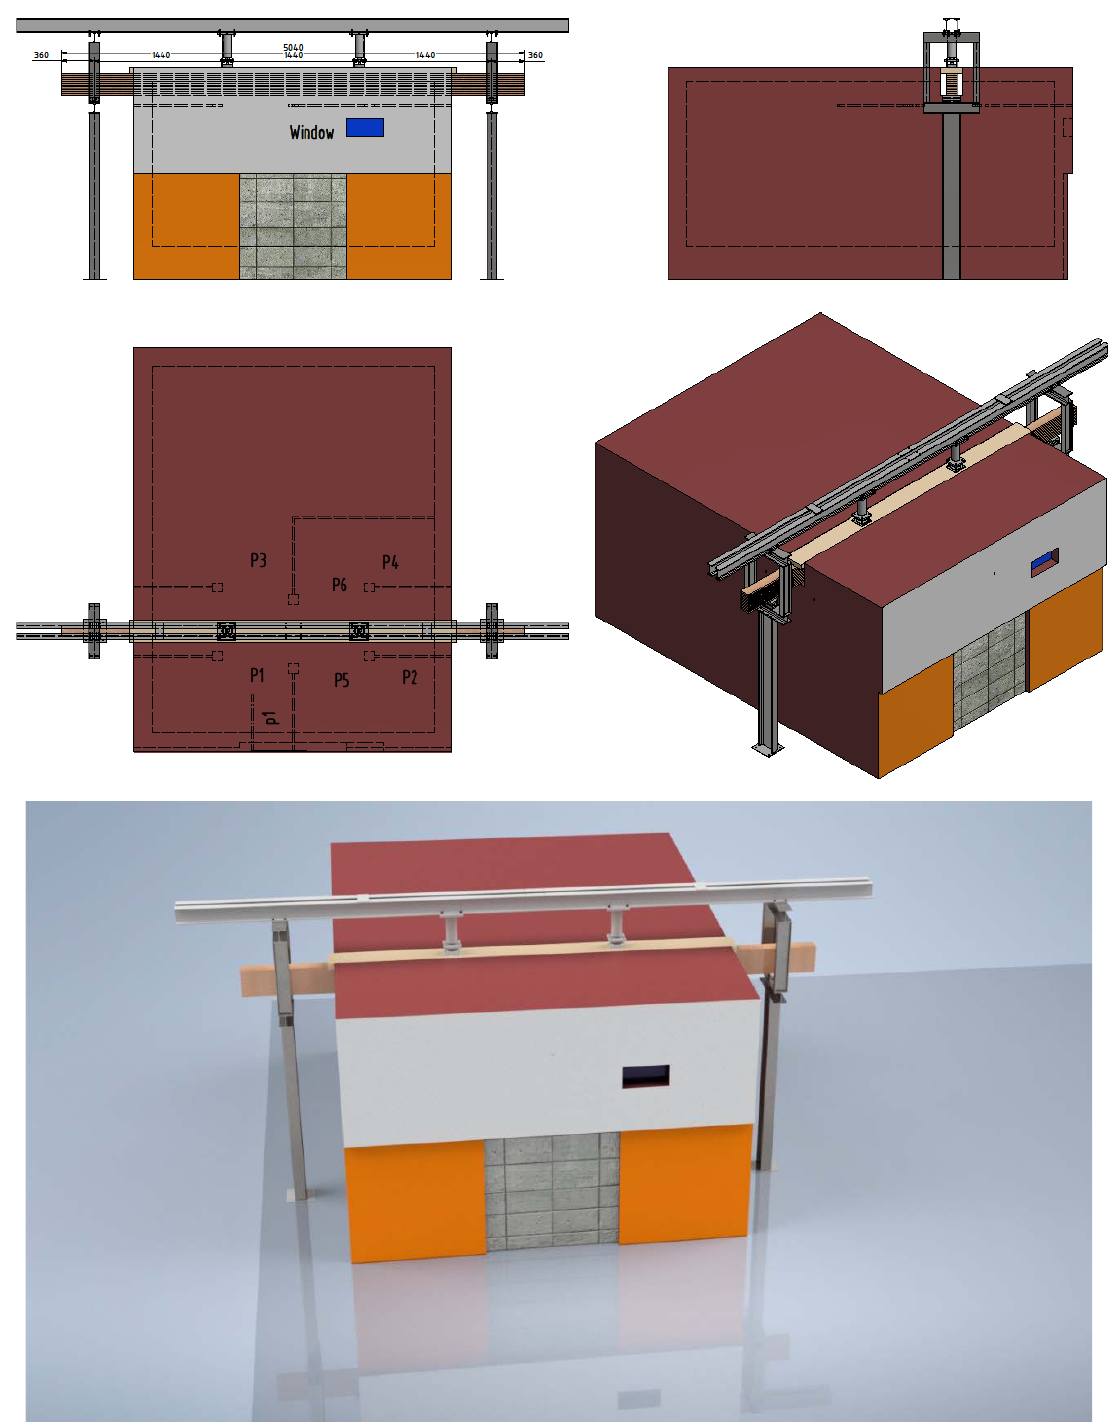
Figure 10. Furnace and general fire test scheme.